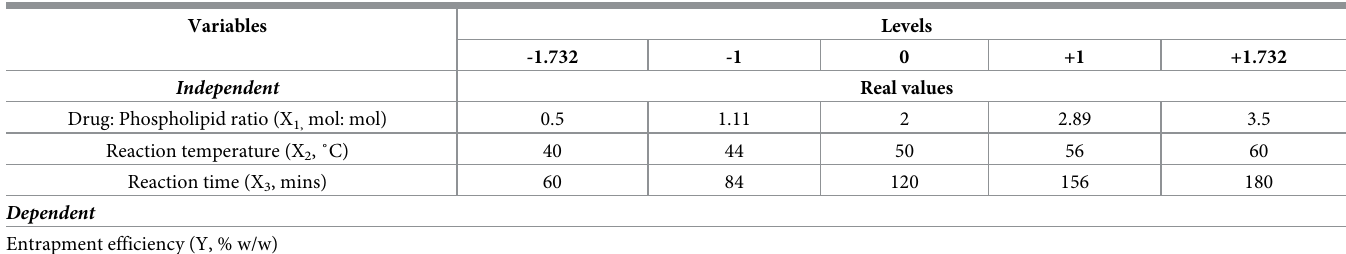
Table 1. Coded levels and “Real” values for each factor under study.